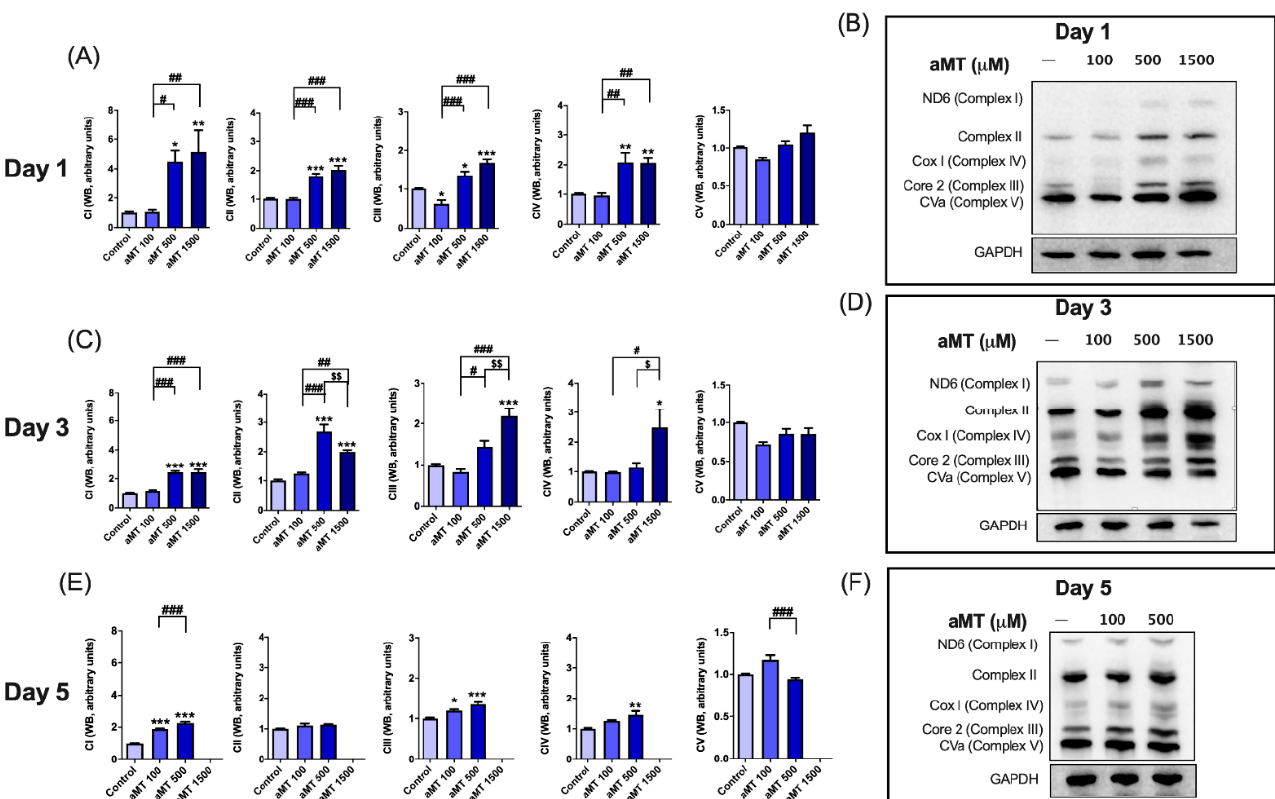
Figure 3. Regulation of OXPHOS protein expression by melatonin in Cal-27 cells. Analysis of OXPHOS protein expression by Western blot after 1 day ( A , B ), 3 days ( C , D ), and 5 days of melatonin treatment ( E , F ). Data for aMT 1500 group are not shown at day 5 because most cells died. n = 6 per group. Data are presented as mean ± SEM. * p < 0.05, ** p < 0.01, *** p < 0.001 vs. control; # p < 0.05, ## p < 0.01, ### p < 0.001 vs. aMT 100 µM group; $ p < 0.05, $$ p < 0.01 vs. aMT 500 µM group.